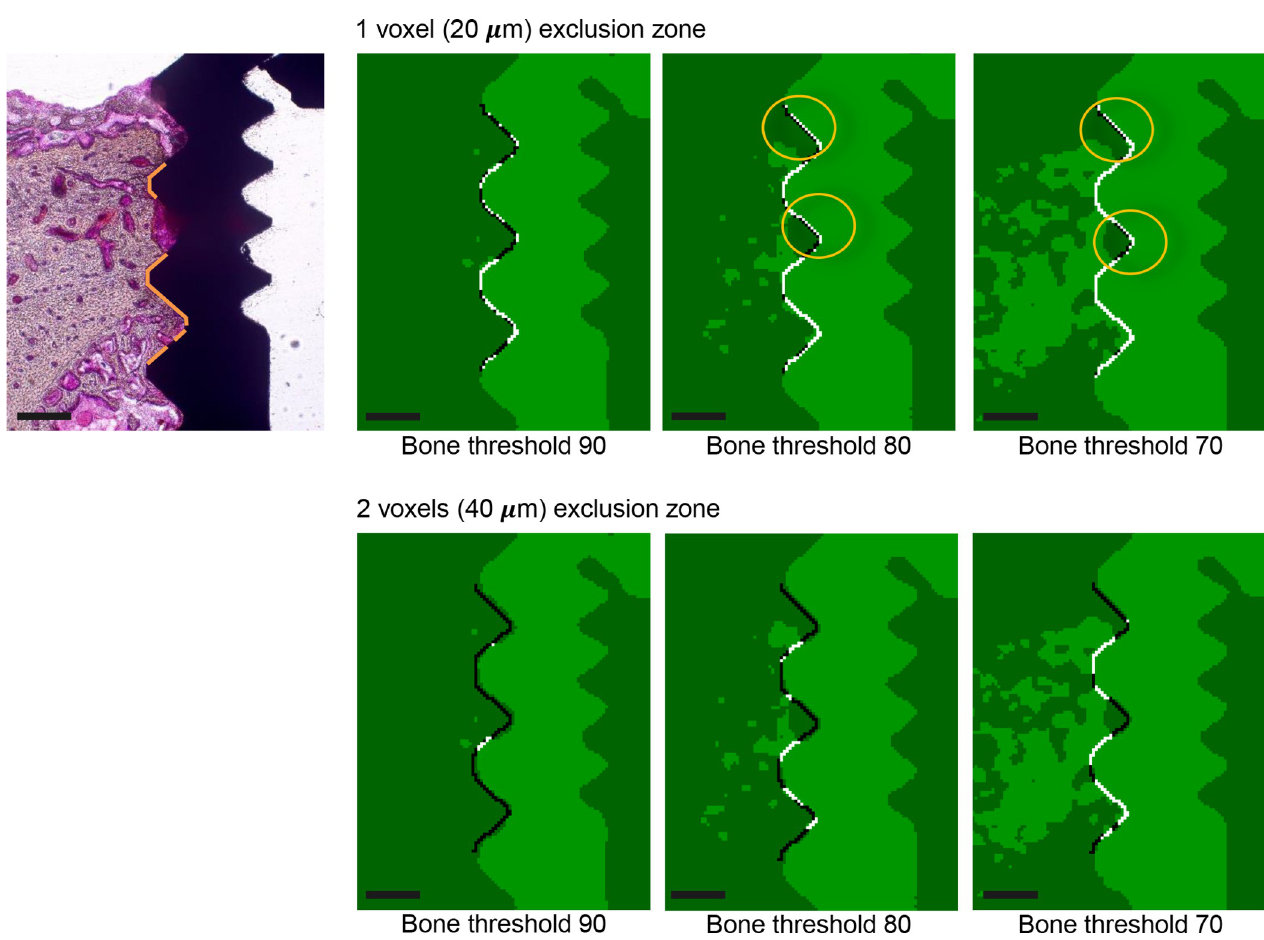
Fig 4. Relationship between the partial volume effect (PVE) and bone threshold at different region of interests. The orange lines on the histological section (left panel) represent actual bone-to implant-contact. The region of interest (ROI) is represented by a black line in the binarized 2D- μ CT sections, and the white area in the ROI indicates the presence of bone under the given bone threshold. A ROI located one voxel (20 μ m) away from the implant surface (upper panels) resulted in false positive bone-to-implant contact (orange circles). A ROI located two voxels (40 μ m) away from the implant surface (lower panels) resulted in no false positive bone-to-implant contact caused by the PVE. Scale bars = 0.5